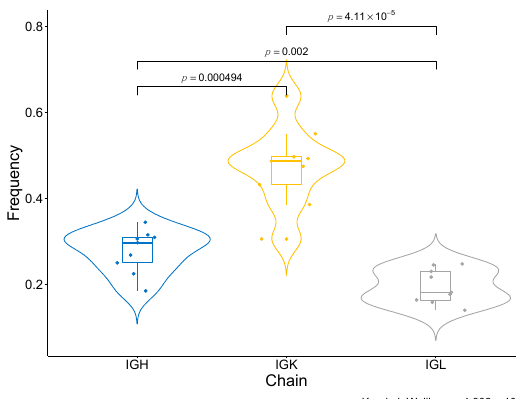
Figure 6. BCR chain diversity among good responders. Comparison of the abundance between BCR chains in good responders. Table 1. Top 5 BCR clonotypes enriched in good responders to Nivolumab.